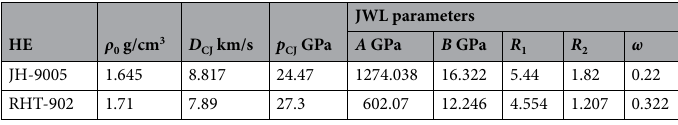
Table 1. JWL parameters used in simulation for